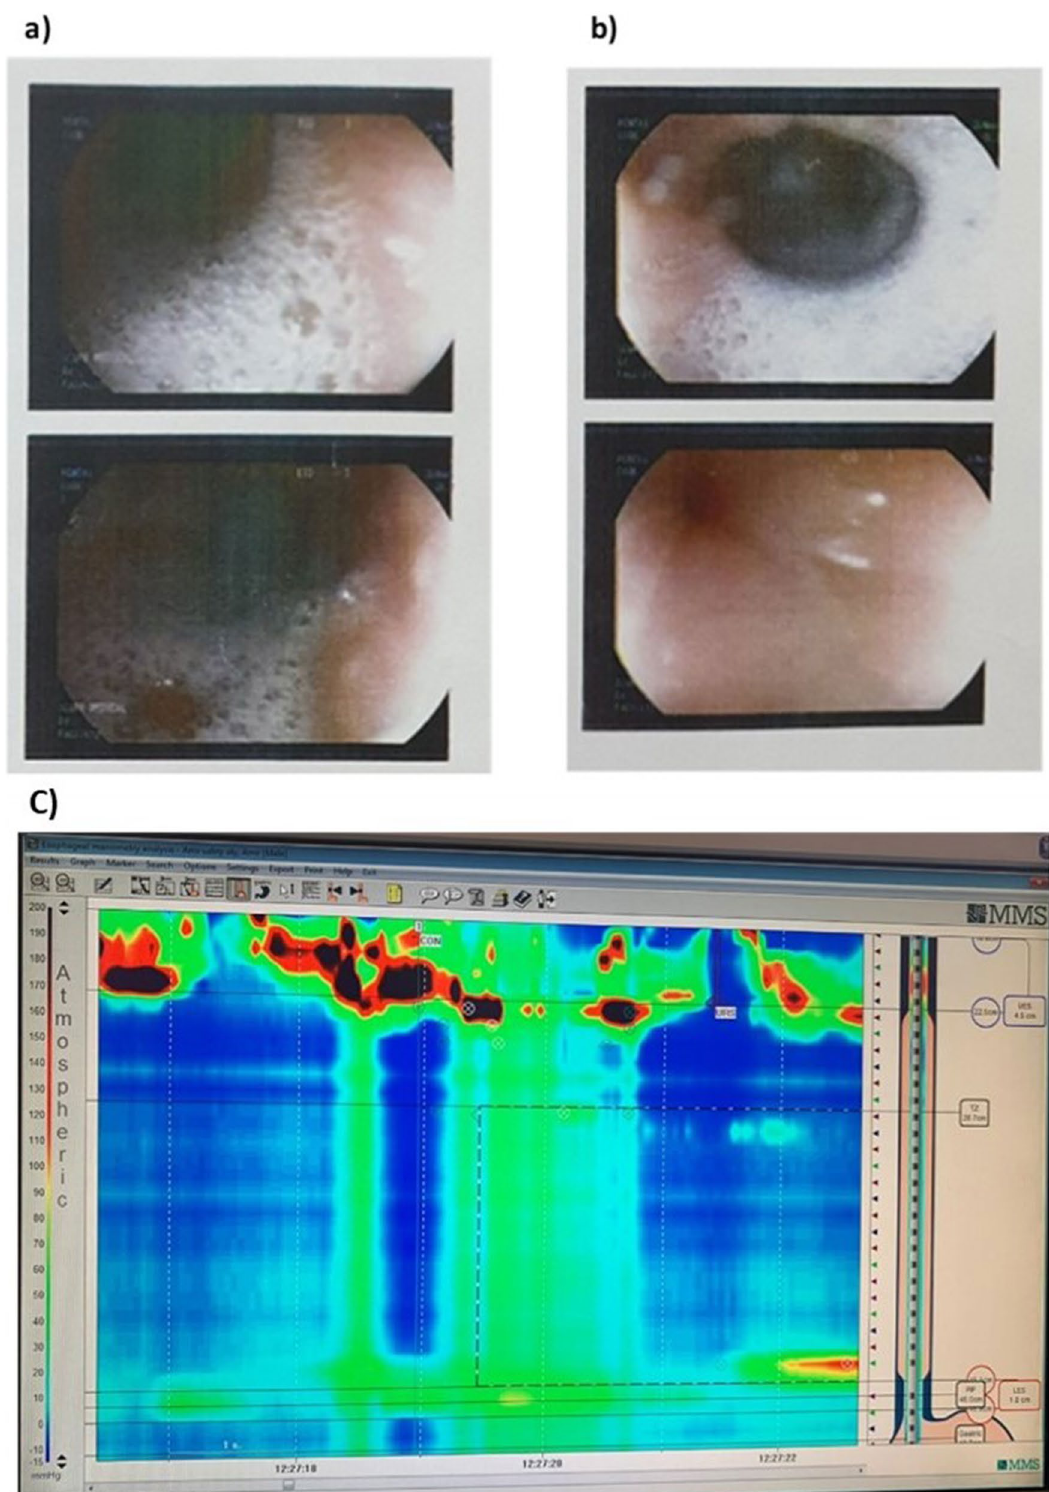
Fig. 2 a Upper gastrointestinal endoscopy showing dilated esophagus and retained fluids. b Tight lower esophageal sphincter. c HRM of achalasia type II: showed the failure of LES relaxation, high resting LES pressure, and absent esophageal peristalsis (100%) with panesophageal pressurization to greater than 30